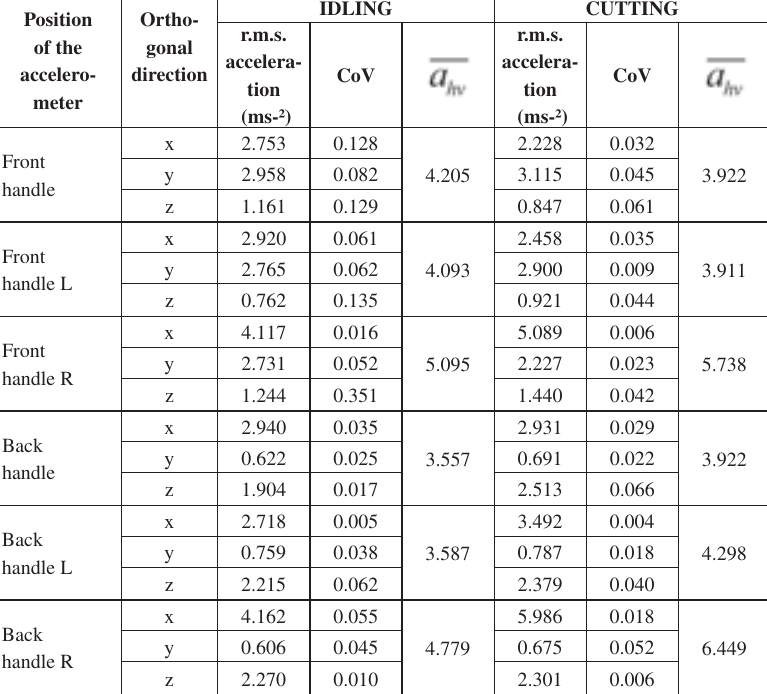
Table 2. Weighted r.m.s. accelerations in three orthogonal directions measured at the front and rear handle of a hedge trimmer during idling and cutting operation. Mean of six